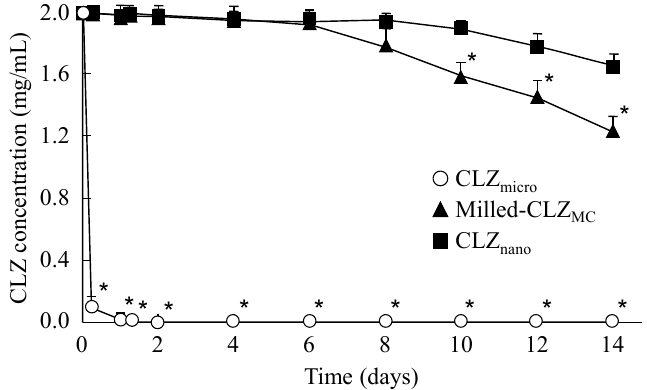
Figure 2. Stability of 0.5% CLZ dispersions as shown in Table 1. The experiment was done in the dark place (20 °C, 14 days). Thedata are presented as means ± S.E. of five independent samples. * p < 0.05, vs. CLZ nano .